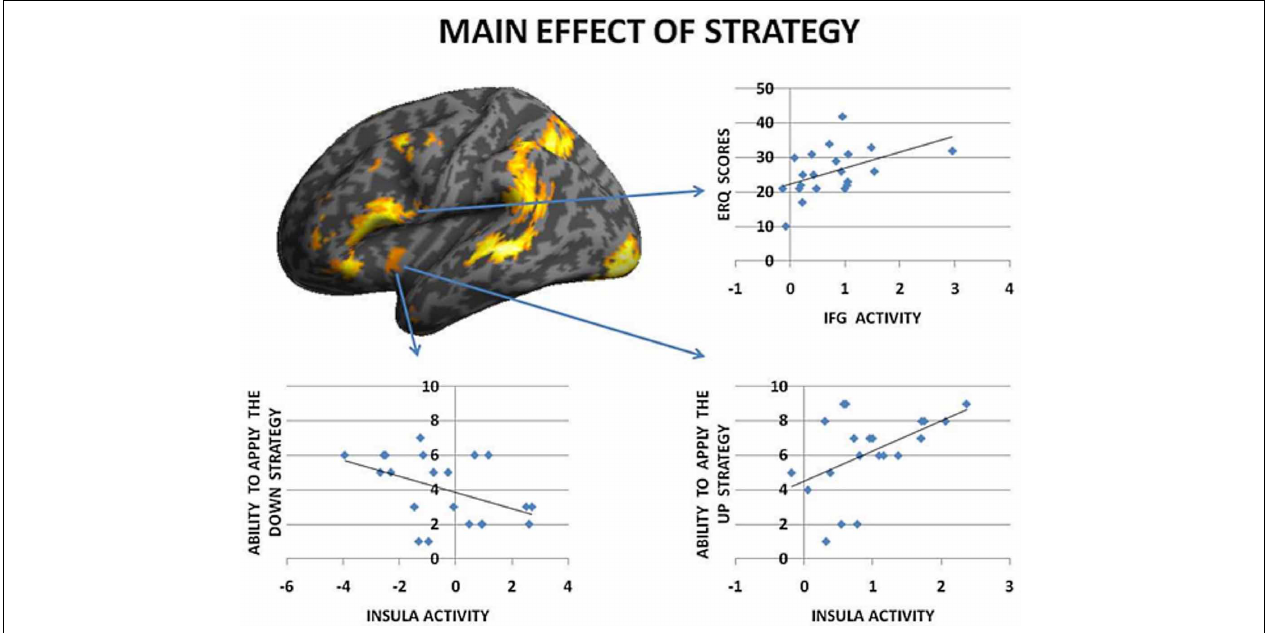
FIGURE 2 | The main effect of strategy returned significant activations for MFG, IFG, and temporo-parietal activations. Overall these regions responded more to up- and down-regulation conditions as compared to look,